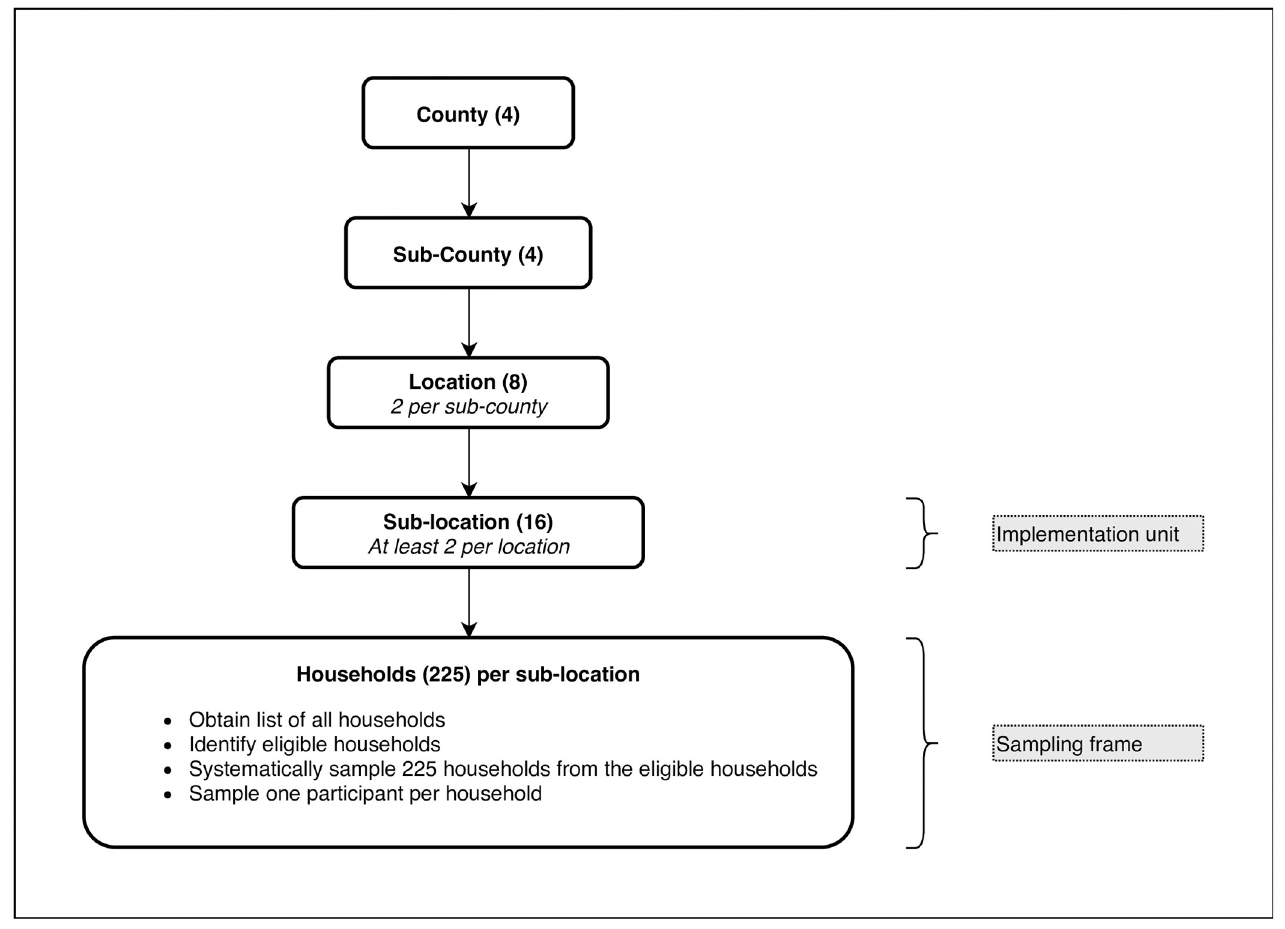
Fig 2. Study profile.